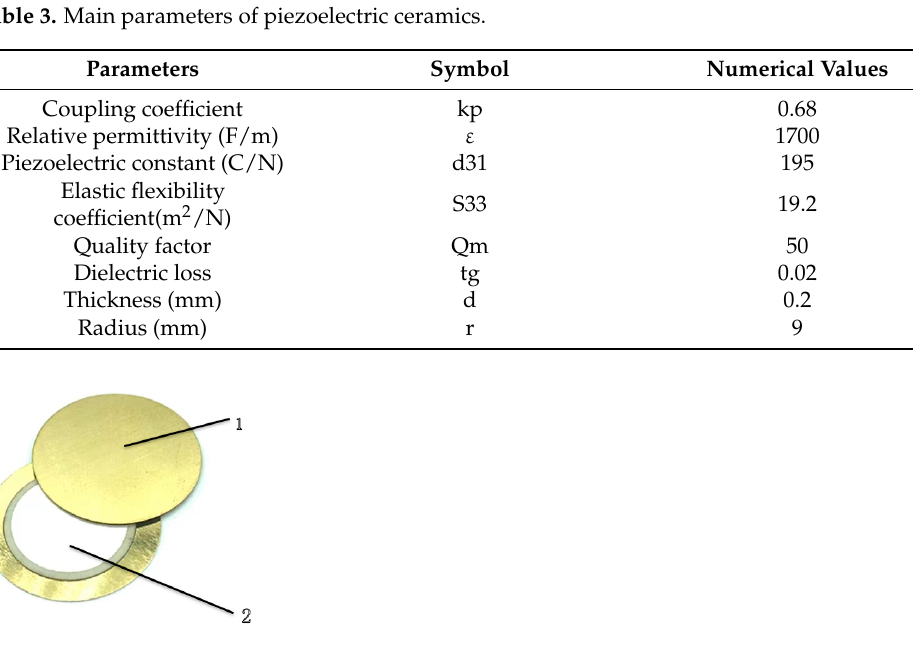
Figure 2. Piezoelectric ceramic sheet: 1—Copper sheet; 2—Piezoelectric ceramics.